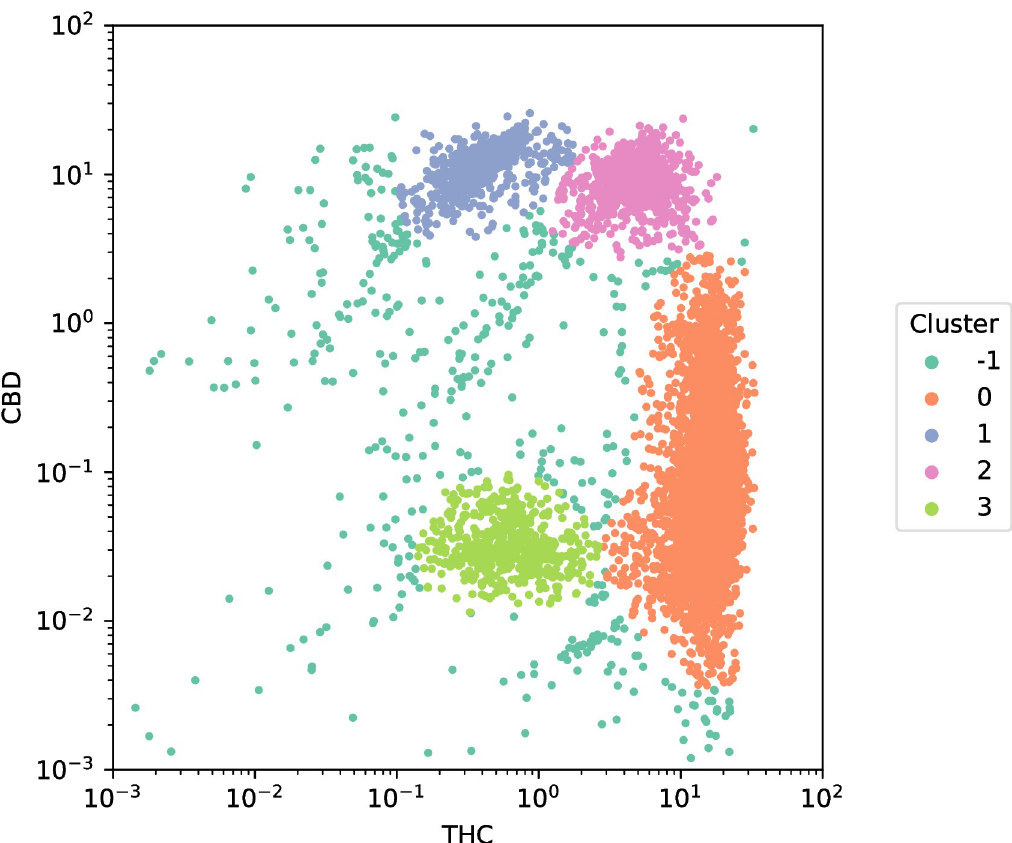
Fig 3. Scatter of THC against CBD concentrations colored by cluster. Four distinctive clusters are apparent in this visualization distinguished by different colors: Cluster 0 in orange contains 8,270 cultivars and is characterized by high concentrations of THC and low concentrations of CBD, most likely intended for recreational use. Clusters 1 in green contains 658 cultivars and is characterized by low concentrations of THC and high concentrations of CBD, most likely intended for medical consumption. Cluster 2 in red contains 869 cultivars and is characterized by high concentrations of both THC and CBD, most likely intended for both recreational and medical use. Cluster 3 in purple contains 536 cultivars and is characterized by low concentrations of both THC and CBD, most likely hemp-type of cultivars. Finally, Cluster -1 in blue contains 433 cultivars that could not be assigned to other clusters using the DBSCAN algorithm, but were labeled using semi-supervised approaches like label